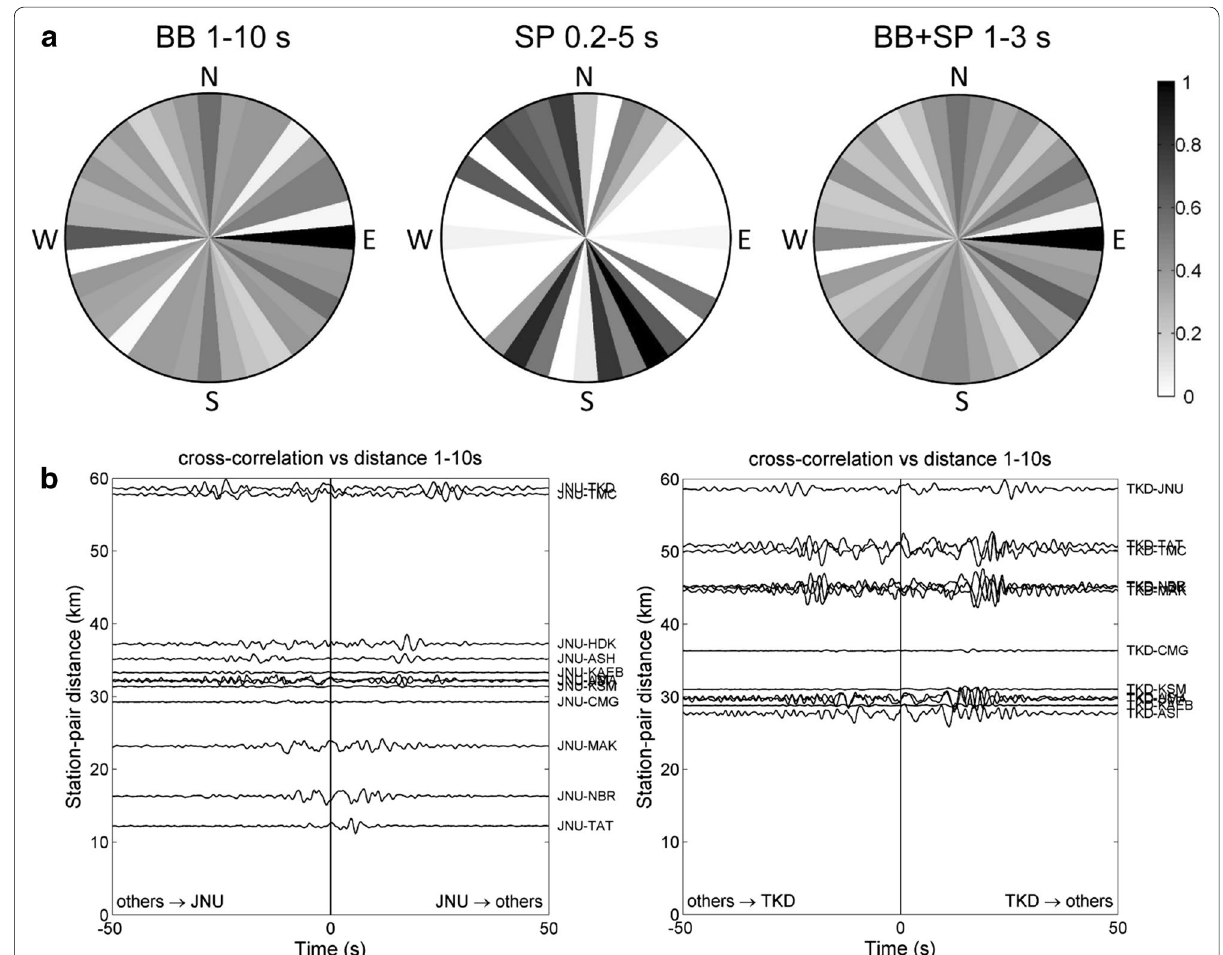
Fig. 6 Relatively homogeneous distribution of ambient seismic noise sources. a Azimuthal dependence of the stacked monthly CCFs presented in Fig. 5 on the normalized amplitudes. For BB station pairs in the 1–10‑s period band, SP station pairs in the 0.2–5‑s period band, and integrated BB and SP station pairs in the 1–3‑s period band. b Two examples of the stacked monthly CCFs versus interstation distance for the BB station pairs corresponding with JNU and